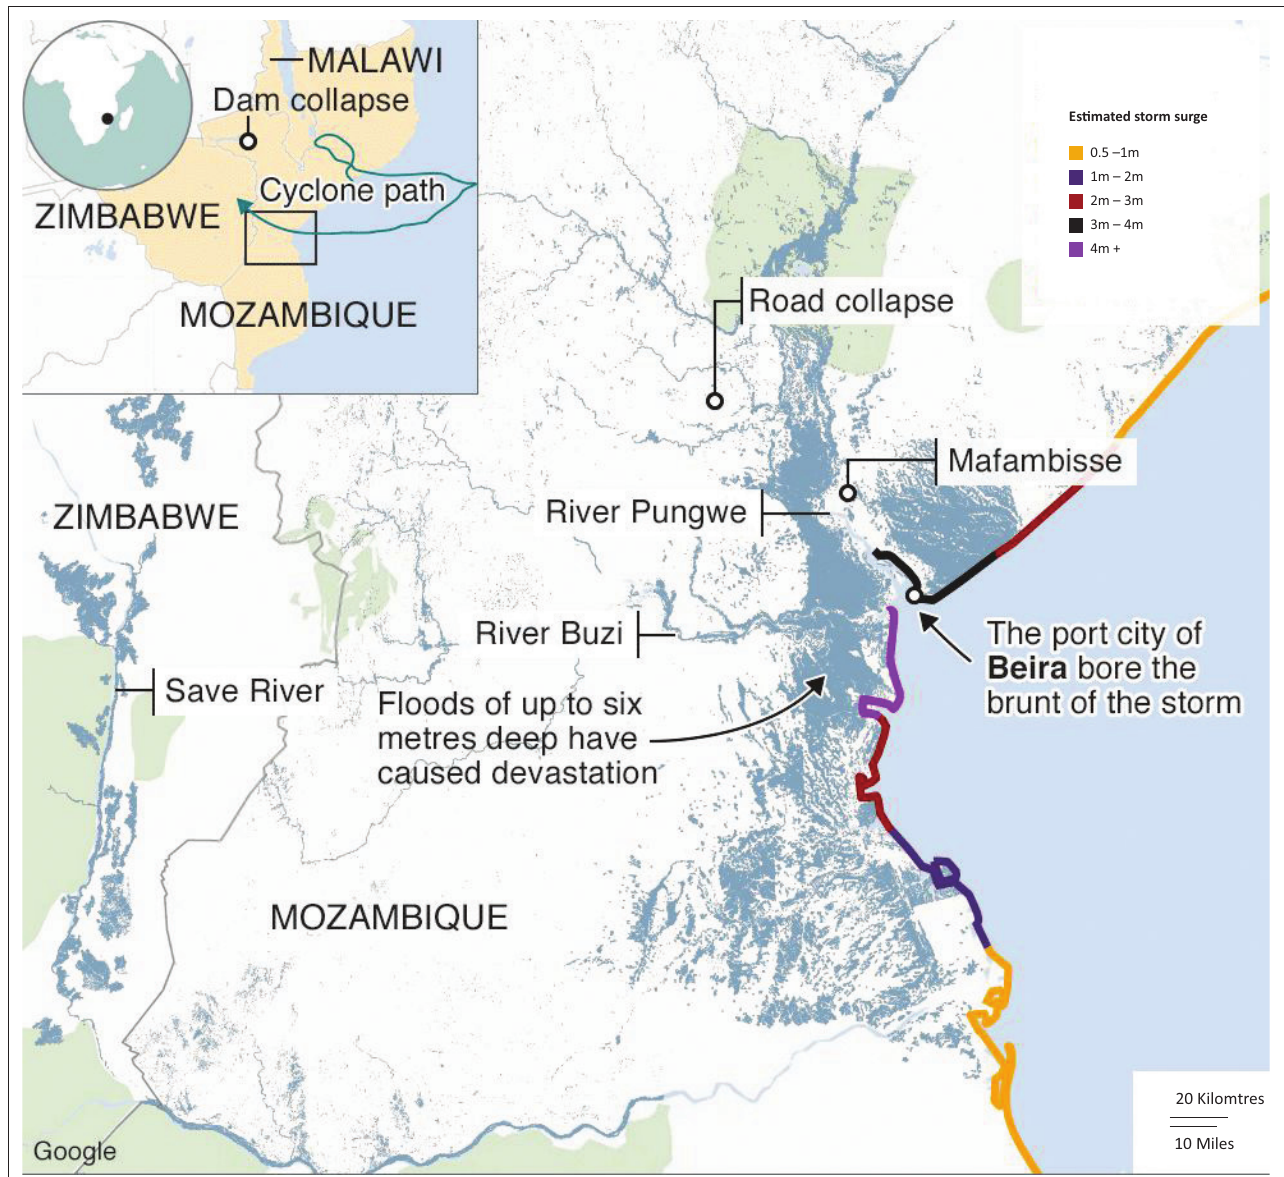
FIGURE 2: Trail of destruction of Cyclone Idai through Mozambique, Malawi and